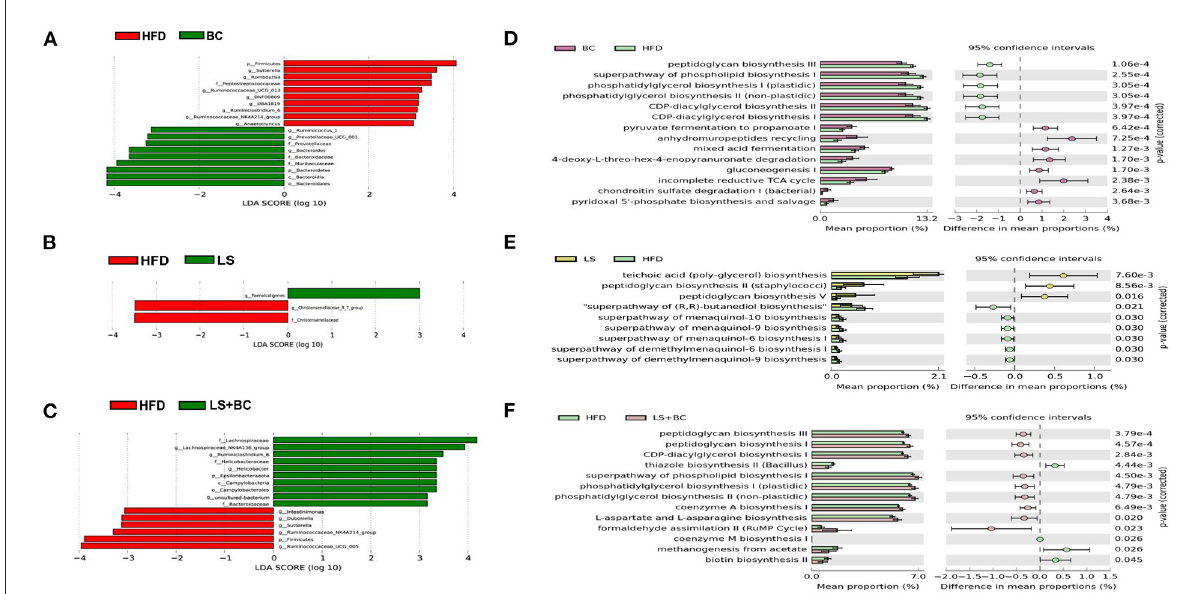
FIGURE4 Different genera and metabolic pathways were found between BC group, LS group, and LS + BC group. (A–C) Linear discriminant analysis (LDA) scores derived from LEfSe analysis, showing the biomarker taxa, (D–F) prediction of the function of microbial genes involved in metabolism by PICRUSt analysis and based on the Welch’s t- test ( p < 0.05). The colored circles represent the 95% confidence intervals calculated by Welch’s inverted